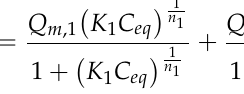
Table 4. Fitted parameters of bimodal Langmuir–Freundlich equation (SD values are shown in pa- rentheses) obtained for ALB adsorption on the Fe-foam.